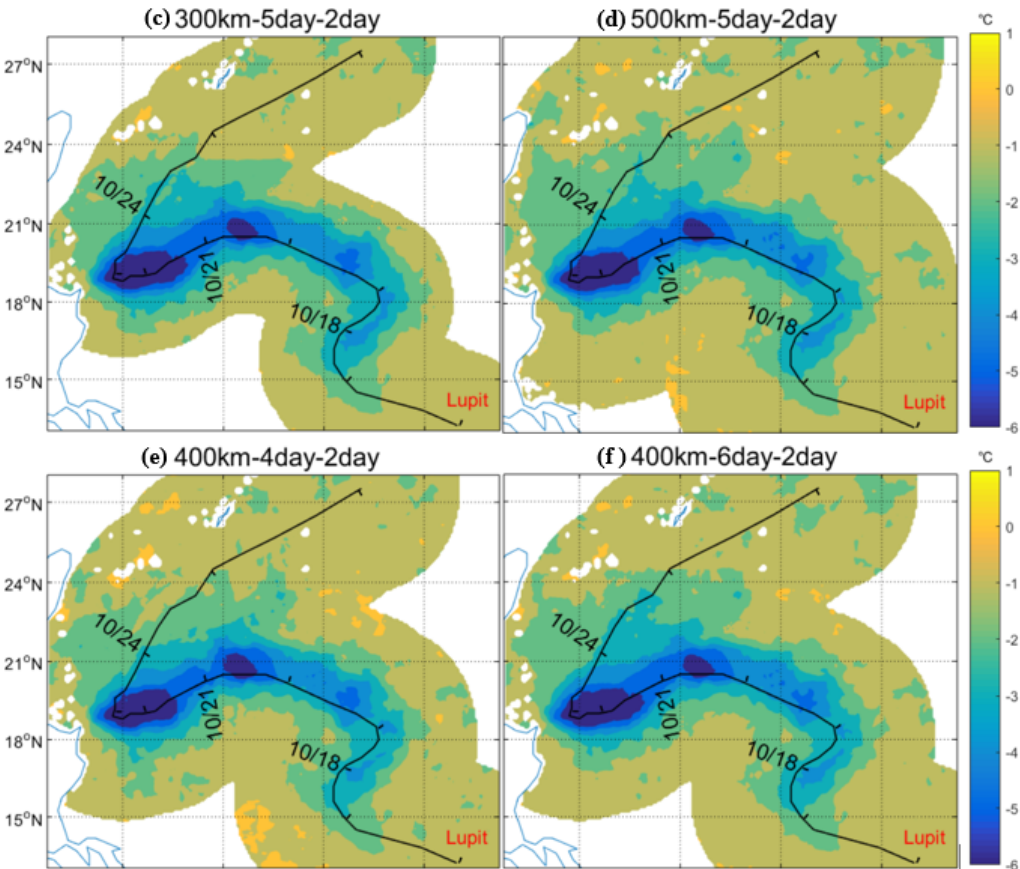
Figure 7. Sensitivity analysis. ( a , b ) Result calculated over five days with a radius of 400 km, changing the background SST two-day average pre-typhoon to a one-day and three-day average. ( c , d ) Results based on the background SST calculated as a two-day average SST pre-typhoon for five days after the typhoon, changing the radius from 400 to 300 and 500 km. ( e , f ) Results based the background SST calculated as a two-day average SST pre-typhoon for a radius of 400 km, changing five days to four and six days.